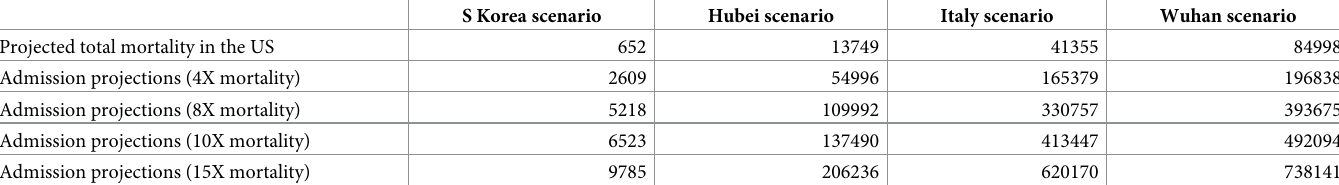
Table 2. Projected mortality and hospital admissions in the United States given statistics from S. Korea, Hubei, Italy, and